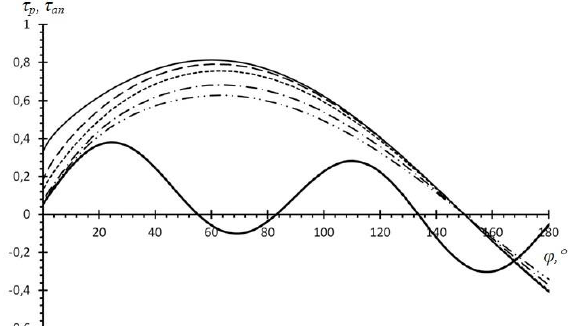
Fig. 1. The normalized components of the torque   acting on the magnetization vector as a function of the angle  .